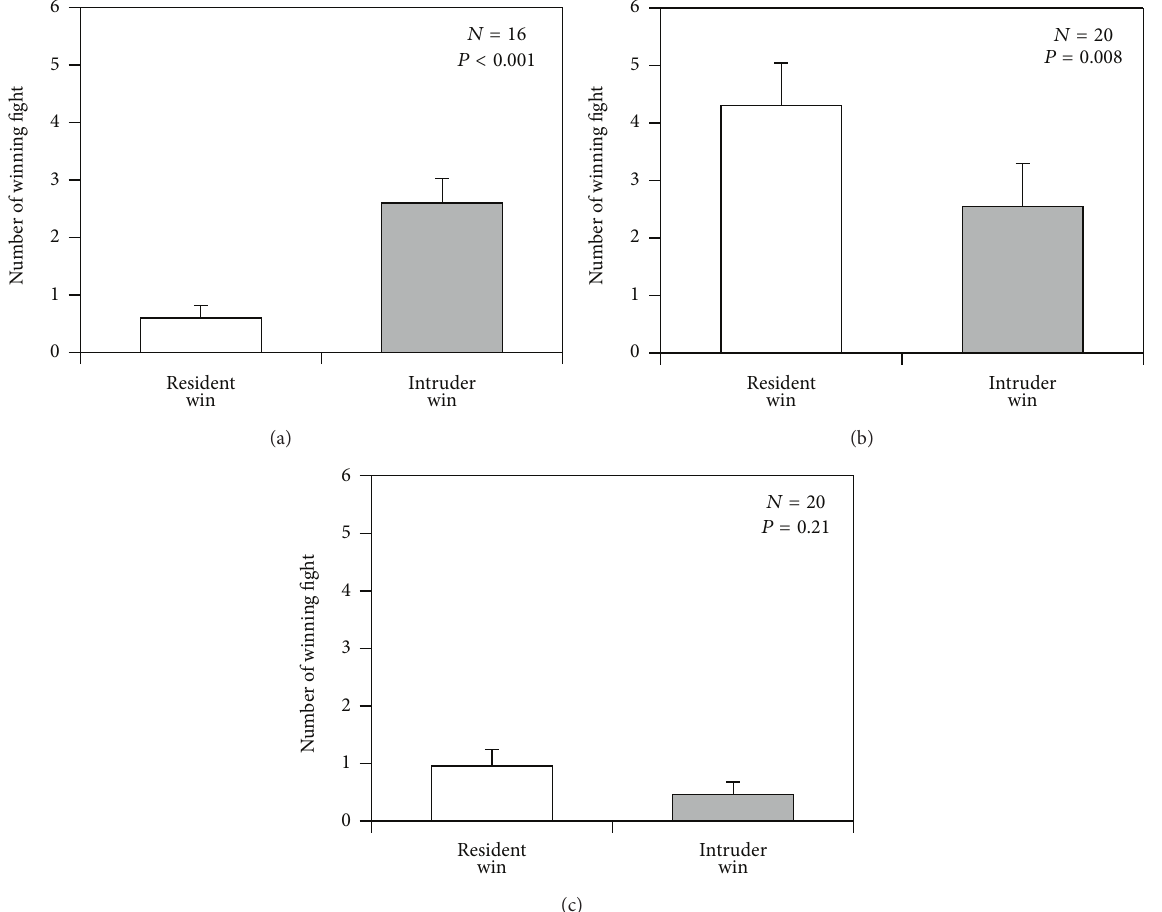
Figure 3: The times individuals took in winning fights in the winner-loser contest (experiment 3). (a) A larger intruder was introduced to the arena where the male had just had a winning experience. (b) A similar-sized intruder was introduced to the arena where the male had just had a winning experience. (c) A similar-sized intruder was introduced to the arena where the male had just had a losing experience. The data are means ±